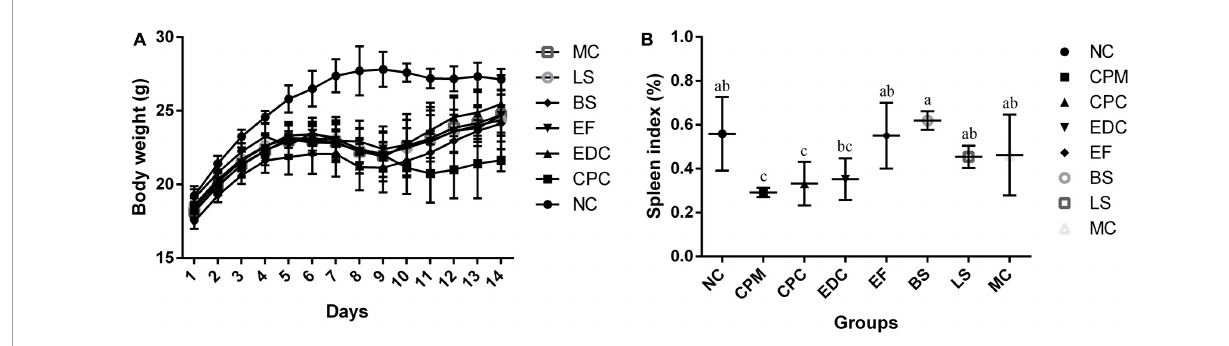
and macrophages under the microscope. In the CPM group, more